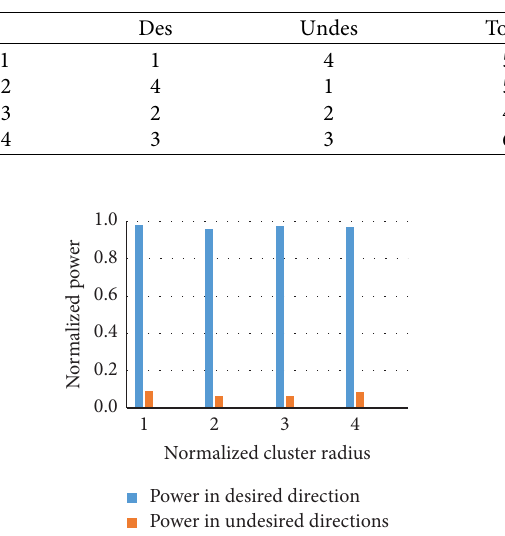
Table 23: Power performance ranking corresponding to null steering at radii 1, 2, 3, and 4 (wavelength normalized).